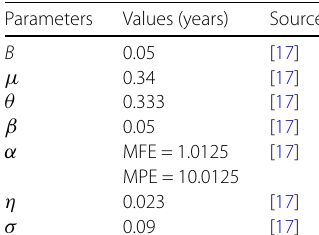
Table 2 Parameter